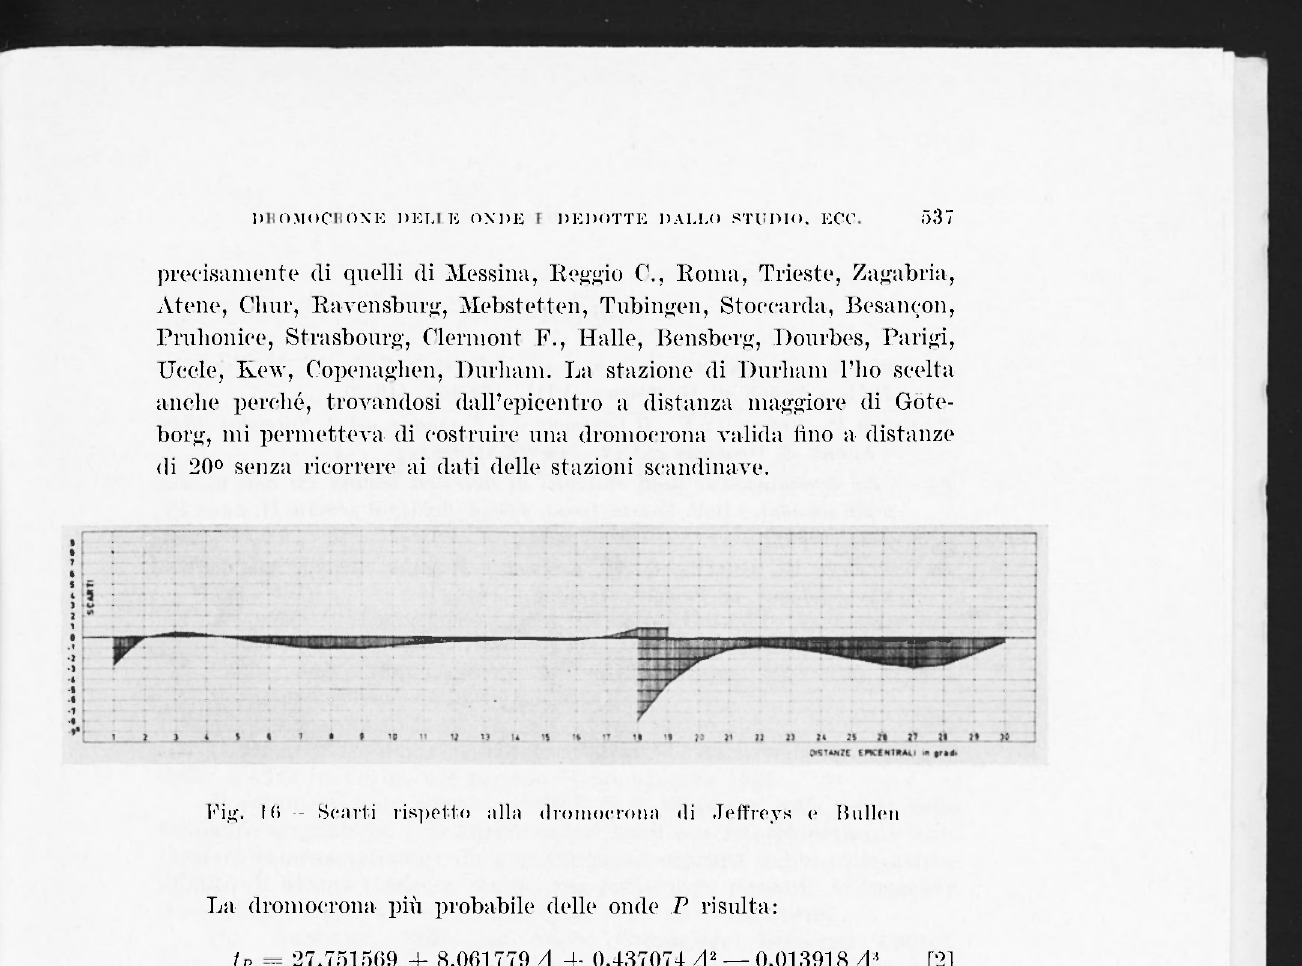
La dromocrona più probabile delle onde P